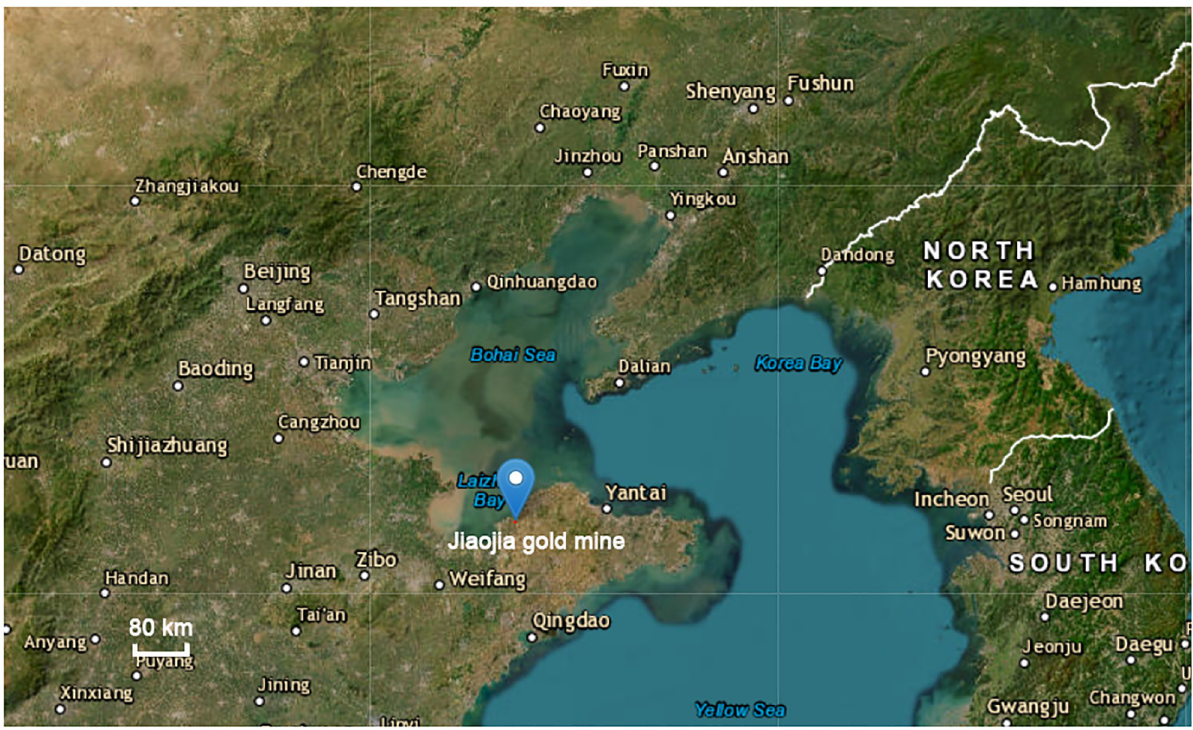
Fig 9. Location of Jiaojia Gold